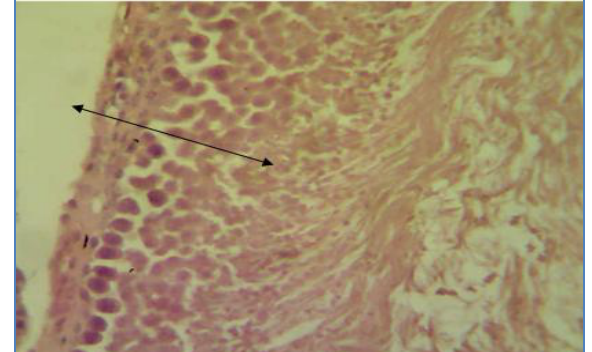
Figure, 16: Section in testis of animal treated with CdCl 2 and Eruca Sativa (G2) shows complete spermatogenesis process ( ), (H and E stain 40X)